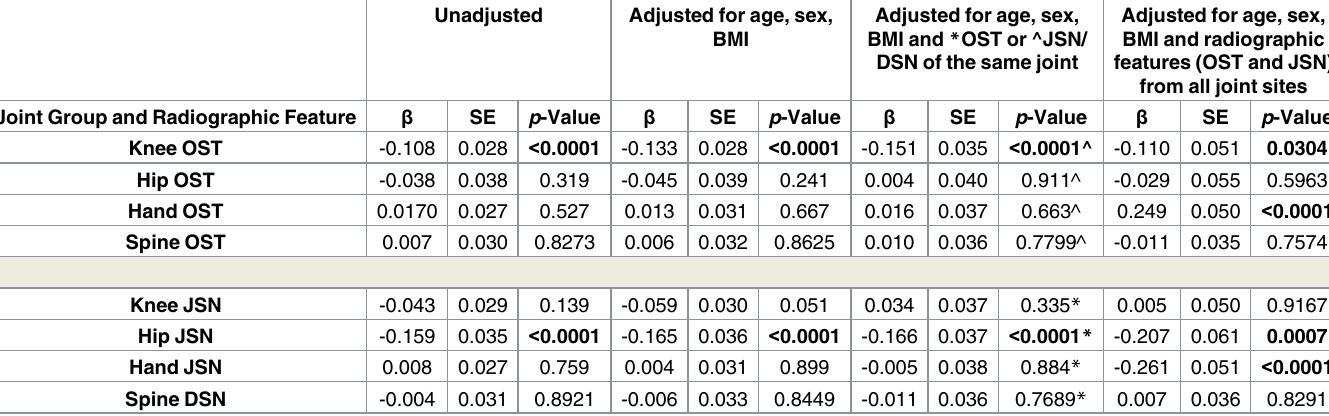
Table 3. Associations of serum PIIANP with radiographic featuresof osteoarthritis in four joint groups.